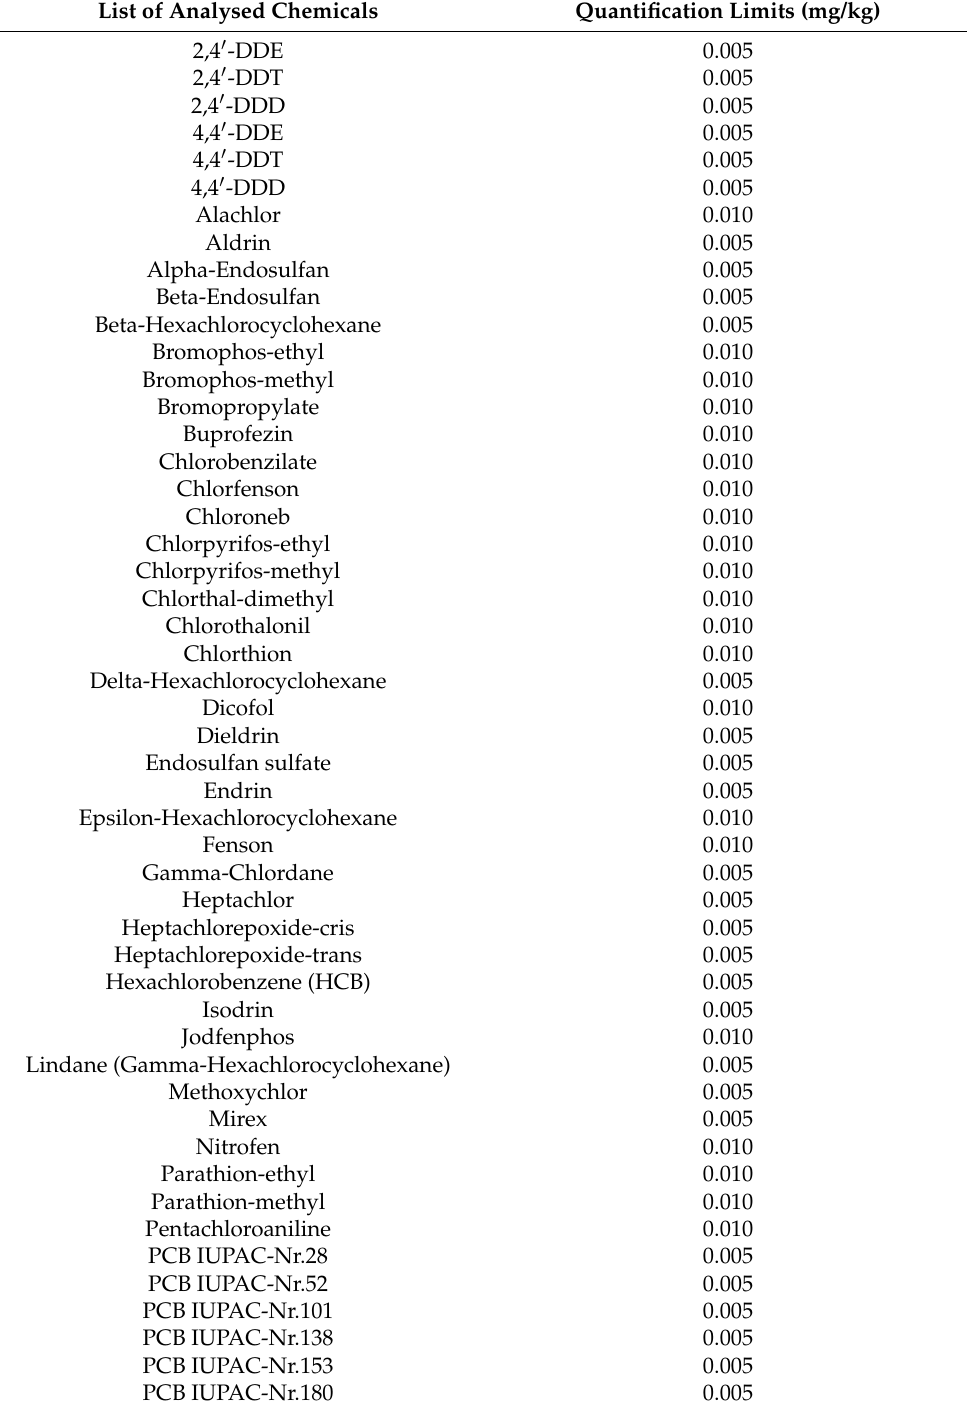
Table 1. The quantification limits of the analysed organochlorine pesticides (OCPs) and polychlori- nated biphenyls (PCBs) in the used detection method, GC-TOF/MS (ASU § 64 LFBG/DFG S19). List of Analysed